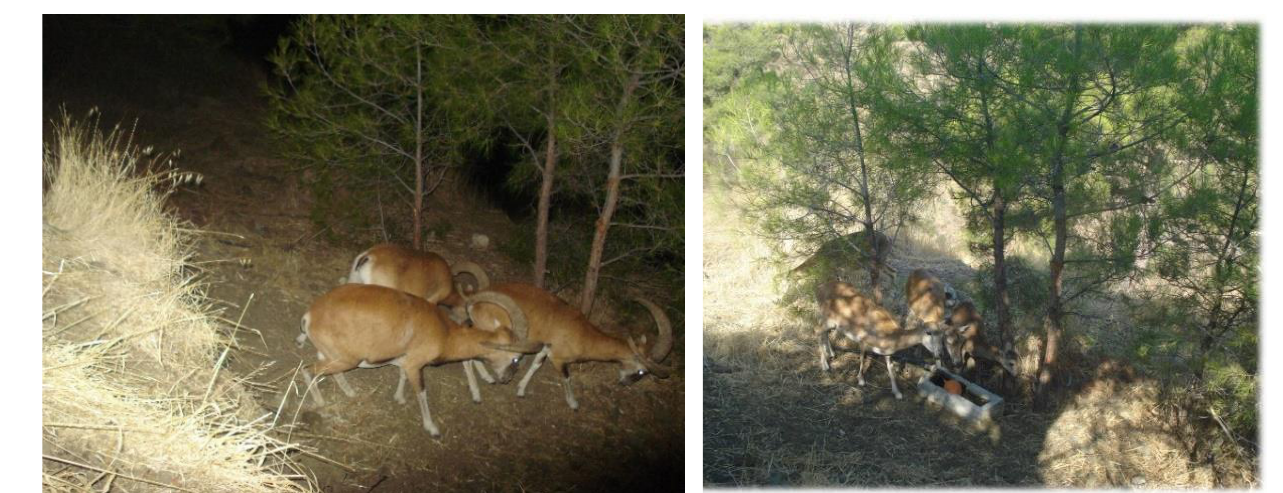
Figure A2. Examples of groups (herds) of Ovis gmelini ophion (Cyprus mouflon) using the water troughs for watering (photos: © Game and Fauna Service, Ministry of Interior, Cyprus).